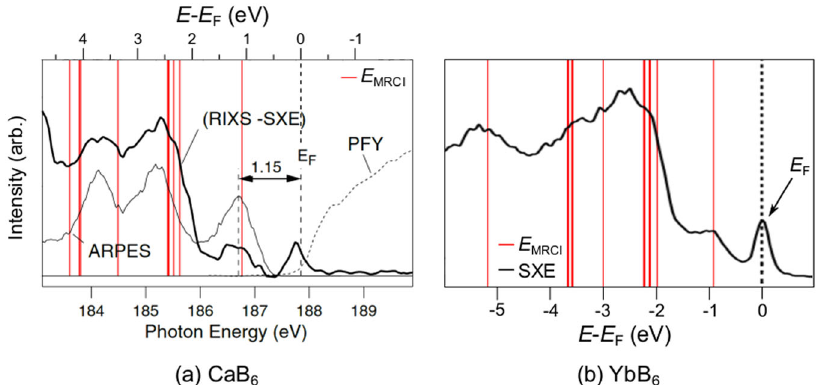
Fig. 3 Comparison of experimental x-ray spectra and calculated MRCI relative energies. A series of experiments was conducted for a CaB 6 and b YbB 6 , involving angle-resolved photoemission spectroscopy (ARPES), surface x-ray photoemission (SXE), resonant-inelastic x-ray scattering (RIXS), and partial fl uorescence-yield (PFY) spectroscopy (in black). Multi-reference con fi guration interaction (MRCI) energies are given for comparison (in red) and all energies are referenced onto the Fermi energy E F . Figure 3(a) reprinted with permission from Denlinger et al. 3 , copyright (2022) by the American Physical Society, and Fig. 3(b) reprinted with permission from Denlinger et al. 20 , copyright (2022) by World Scienti fi c Publishing Co. PTE. LTD. through the Copyright Clearance Center (CCC).